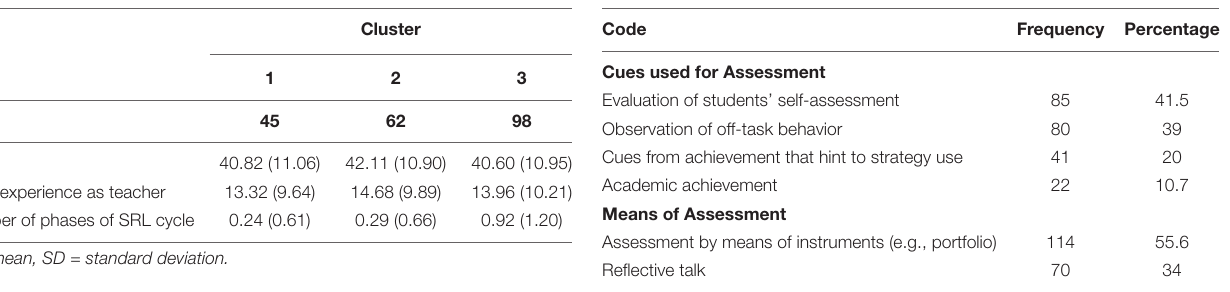
TABLE 4 | Teacher characteristics of the three cluster groups (M and SD). TABLE 5 | Frequencies of codes for teachers’ ideas about assessing